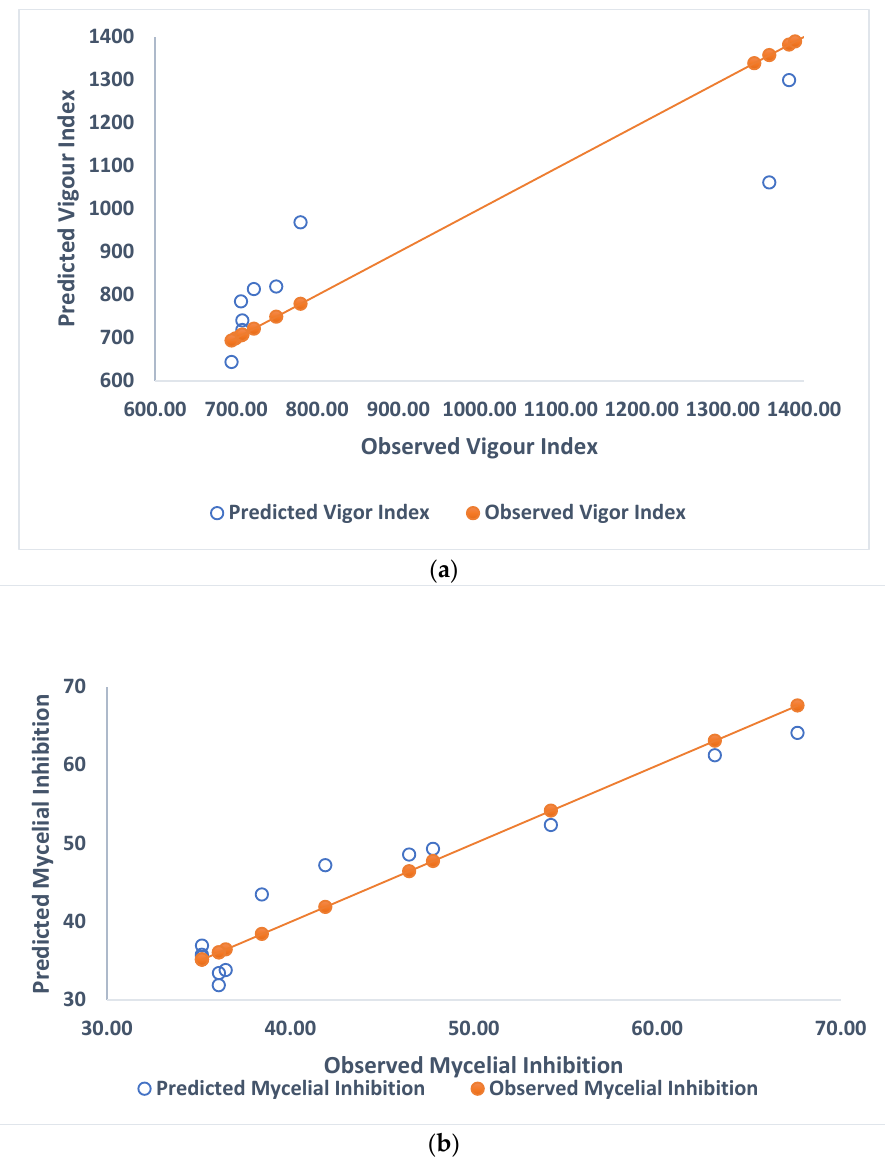
Figure 2. Relationship of observed and predicted values of the average vigour index (a) of tomato, cowpea and French bean after treatment of lateritic Pseudomonads and average mycelial inhibition (b) of Rhizoctonia solani , Sclerotinia sclerotiorum and Sclerotium rolfsii by lateritic Pseudomonads based on multiple linear regression (stepwise method). Table 7. Pearson correlation coefficients of average mycelial inhibition (AMI) (dependent variable) with the production of various secondary metabolite (independent variables) of lateritic Pseudomonads and associated isolates (using t -Test).